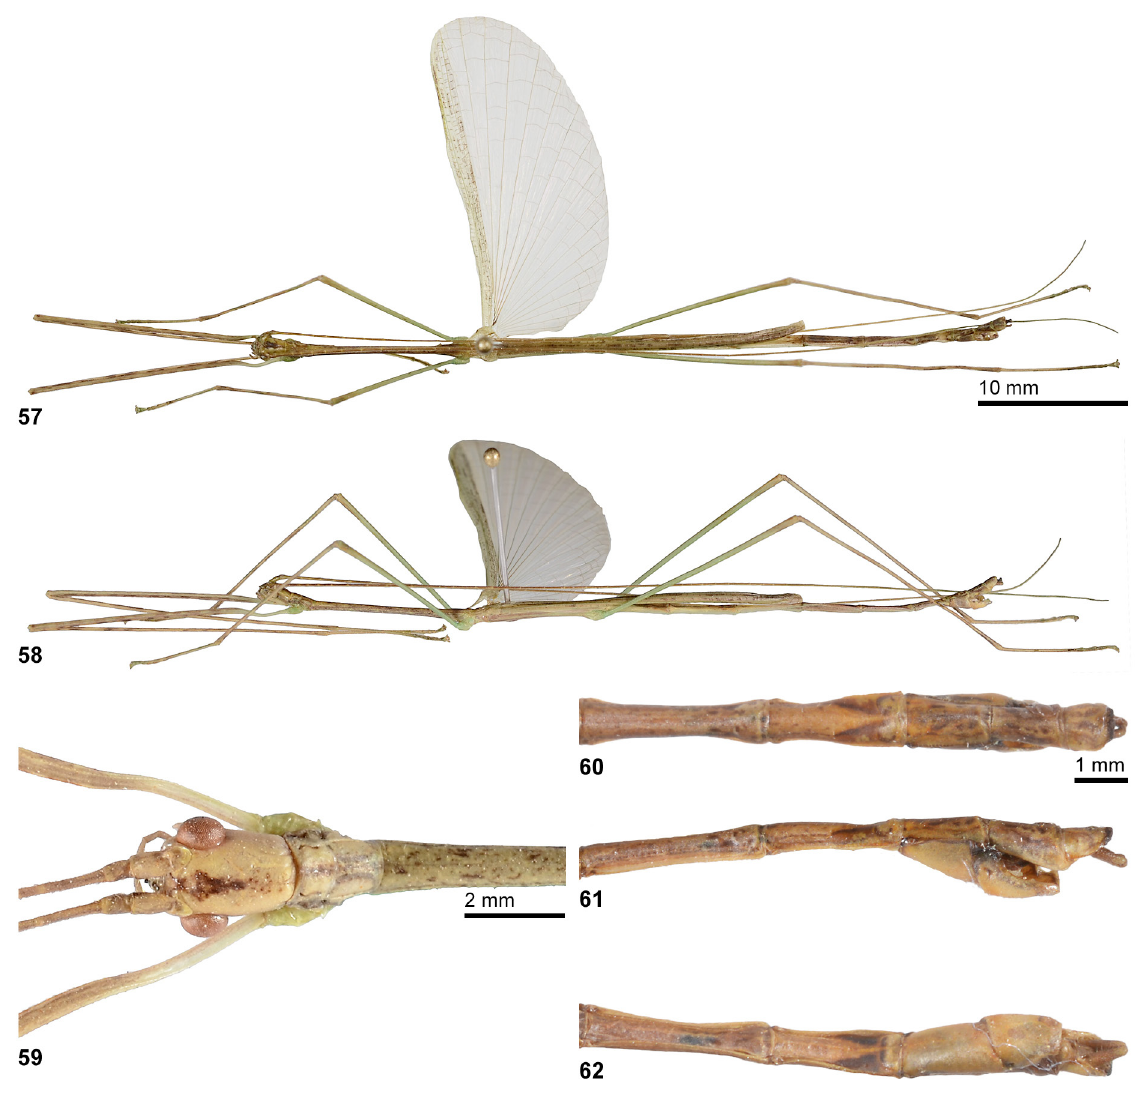
Figs 57–62. Phantasca nigrolineata sp. nov. Paratypes, ♂♂ . 57 . Habitus, dorsal view. 58 . Habitus, lateral view. 59 . Head, pro- and mesothorax, dorsal view. 60 . Apex of abdomen, dorsal view. 61 . Apex of abdomen, lateral view. 62 . Apex of abdomen, ventral